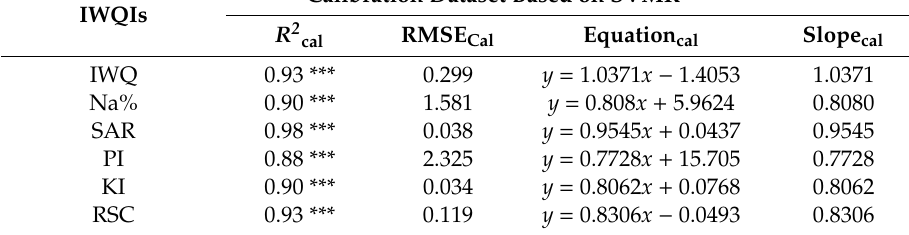
Calibration Dataset Based on